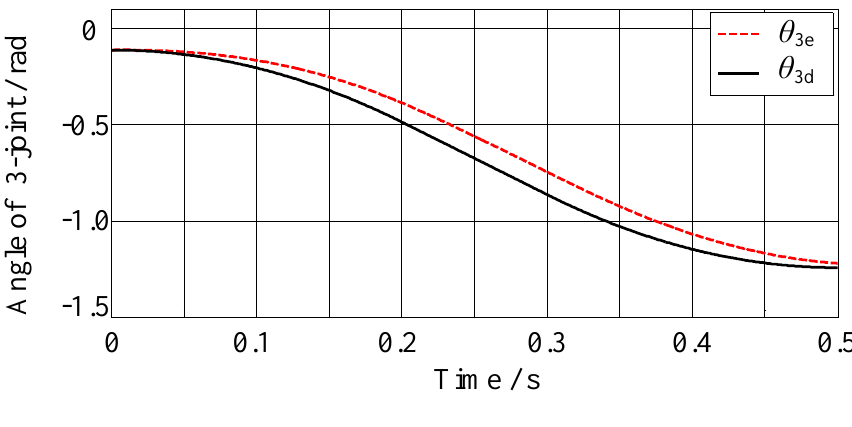
Figure 12. The desired and actual angular displacements of the 3-joint.